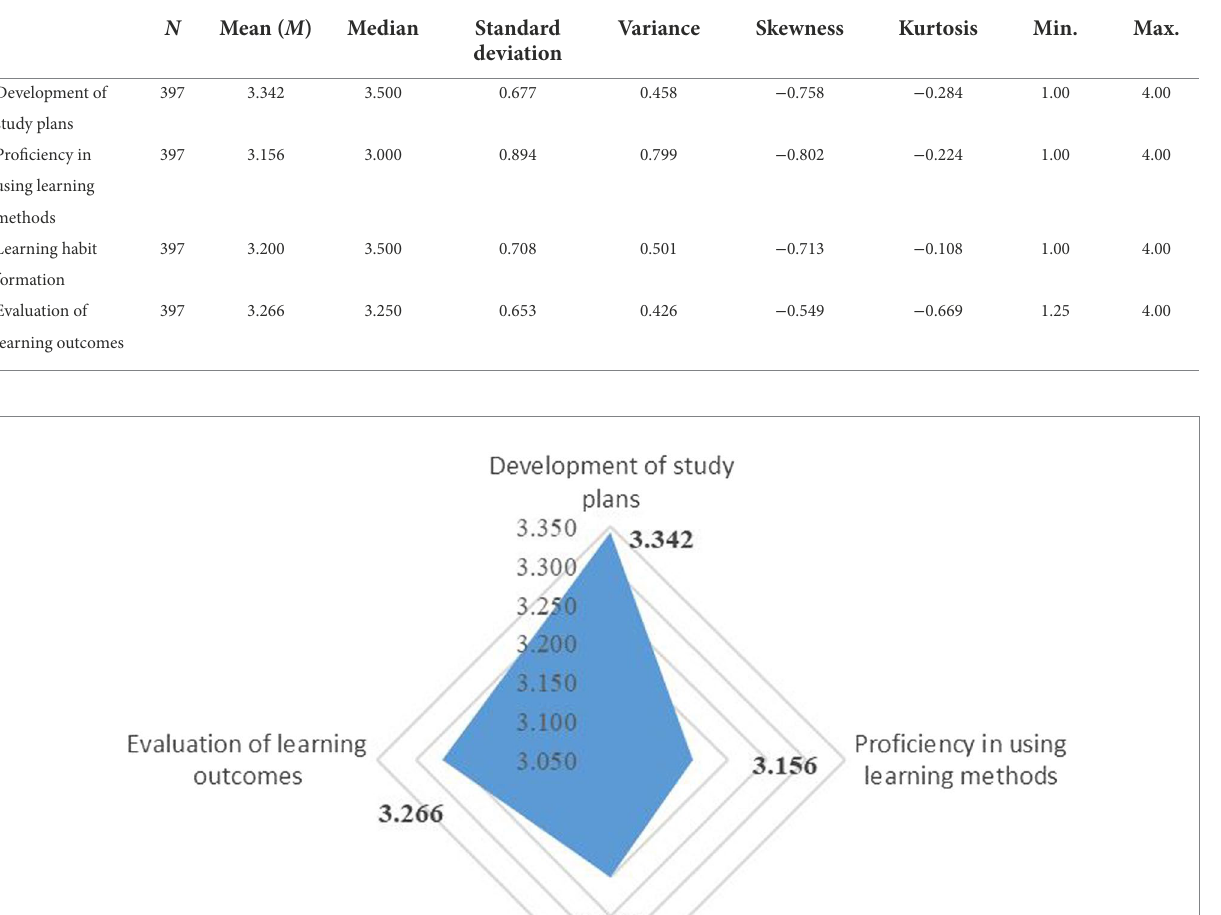
TABLE 4 Descriptive results of teachers’ autonomous learning capacity by subdimension.